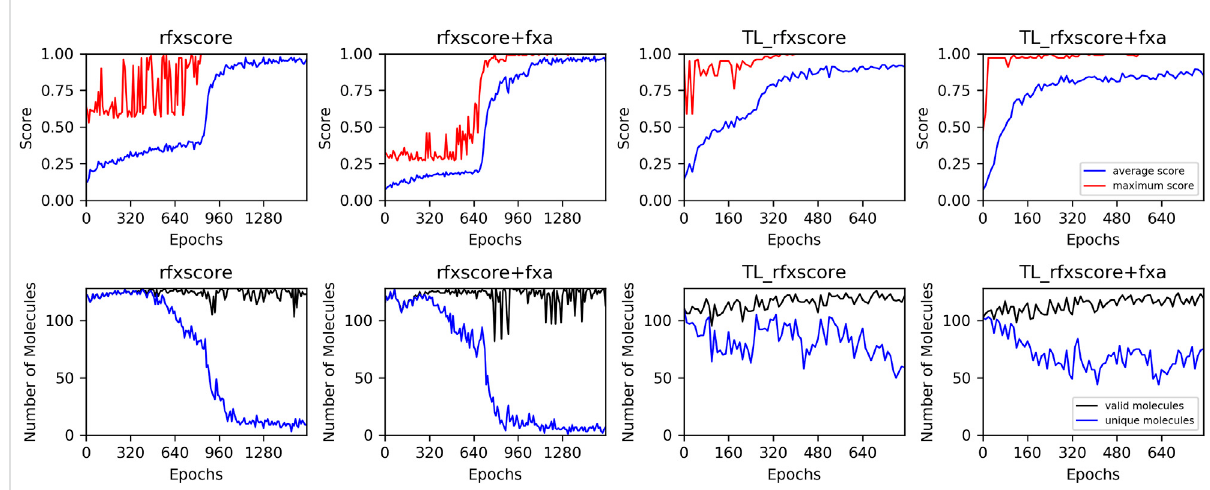
FIGURE 10 Training performance of REINVENT runs. Upper row: average (blue) and maximum (red) score, lower row: number of valid (black) and unique (blue) generated molecules.